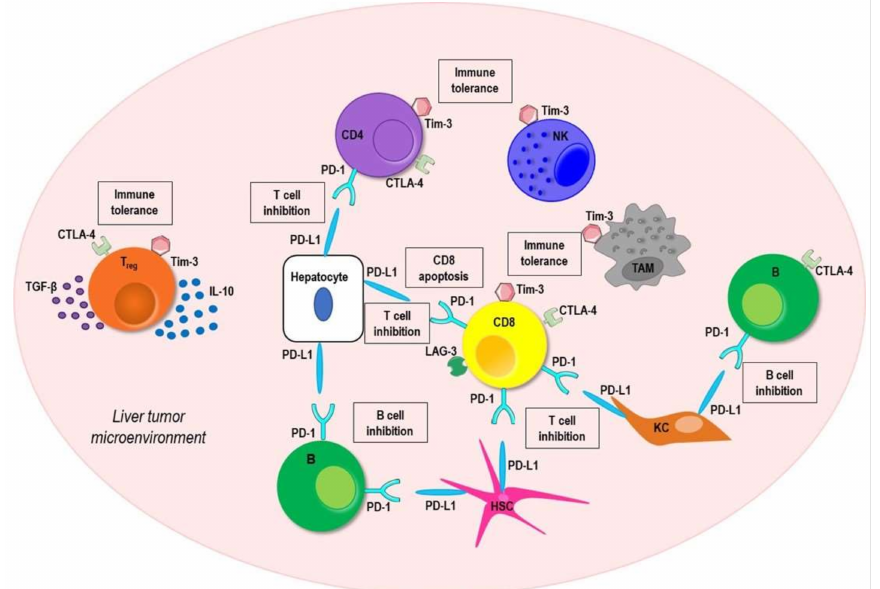
Figure 2. Schematic illustration of immune inhibitory interactions in the liver hepatocellular carci- noma microenvironment. Tumor-specific infiltrating CD4 T helper cells exhibit a great expression of immune checkpoint molecules programmed cell death-1 (PD-1), cytotoxic T-lymphocyte antigen 4 (CTLA-4), and mucin domain molecule 3 (TIM-3), whereas tumor-specific infiltrating CD8 T cells show a high expression of PD-1, CTLA-4, TIM-3, and lymphocyte activating gene 3 protein (LAG-3) on their surface. High levels of PD-1 and CTLA-4 are also displayed on the B cell surface. The interaction between PD-1 and its ligand PD-L1 expressed on hepatocytes, Kupffer cells (KCs), and hepatic stellate cells (HSCs) promotes T and B cell inhibition and induces CD8 T cells apoptosis. CTLA-4 inhibits immune functions favoring tumor growth. TIM-3 is involved in immune response regulation and immune tolerance induction. Besides T cells, tumor associated macrophages (TAMs) and natural killer (NK) cells markedly express